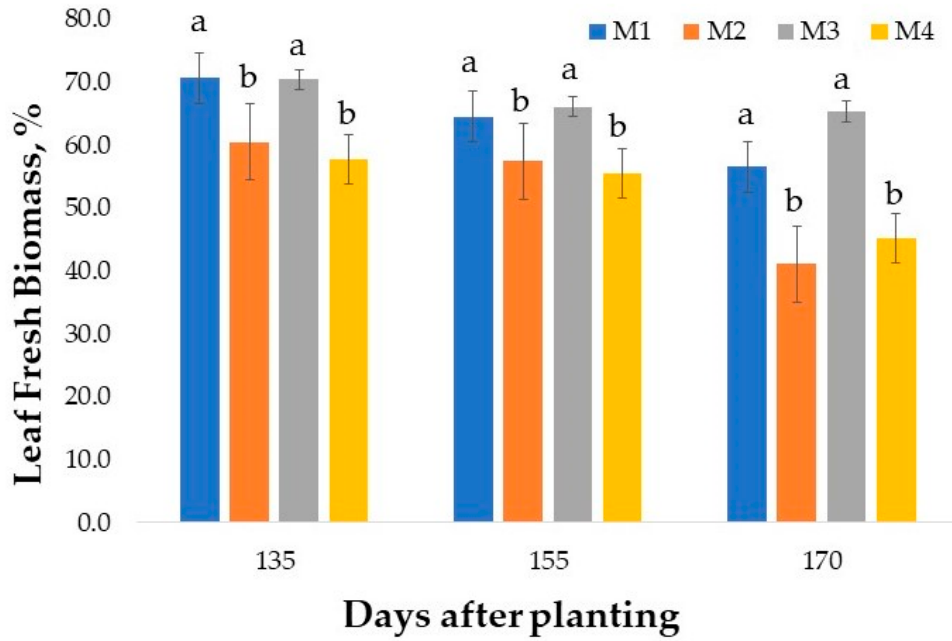
Figure 2. Variation among four mountain mint varieties for fresh leaf biomass as a percentage of whole plant biomass at three times of harvest. Alabama, USA. Bars with same letter are not significantly different at p ≤ 0.05.